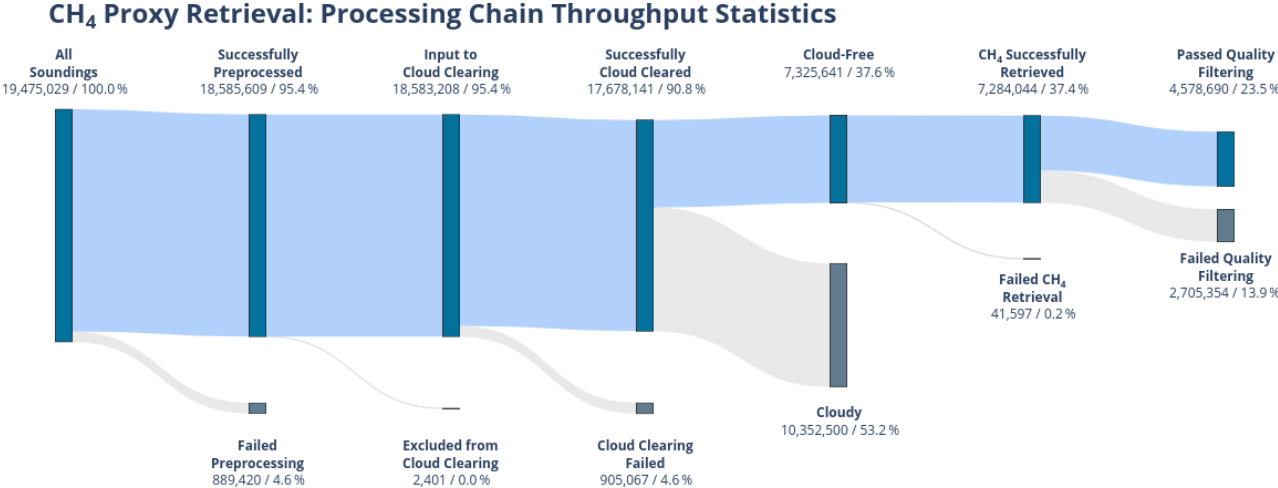
Figure 3. Sankey diagram detailing the retrieval throughput at each step of the processing chain for the GOSAT Proxy XCH 4 retrieval. As well as the absolute number of soundings, the percentage relative to the initial total is also